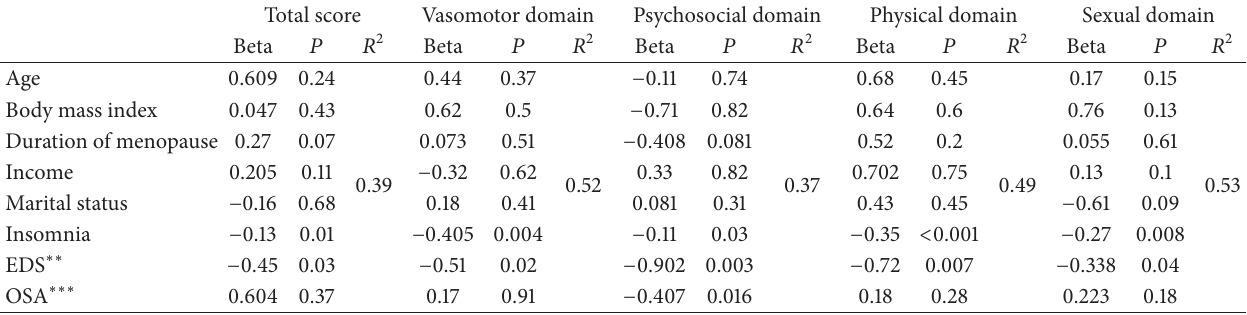
∗ MENQOL: menopause specific quality of life.